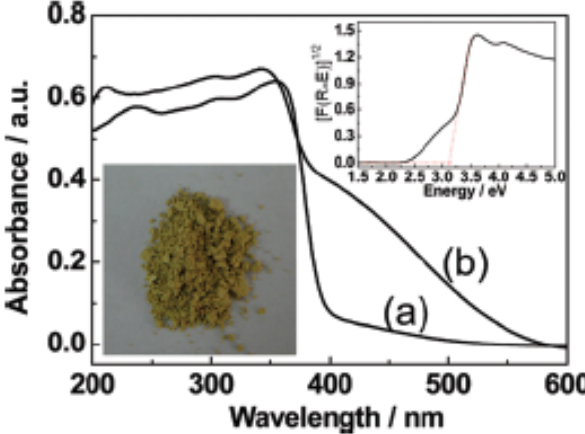
sheets and ( b ) nitrogen Figure 6. UV-visible absorption spectra of ( a ) pure anatase TiO 2 doped anatase TiO sheets; the insets in the upper right and lower left corners are the plot 2 of the transformed Kubelka-Munk function vs. the energy of light and the optical photograph of nitrogen doped anatase TiO sheets, respectively. Reprinted with permission 2 from ref. [48]. Copyright 2009 American Chemical